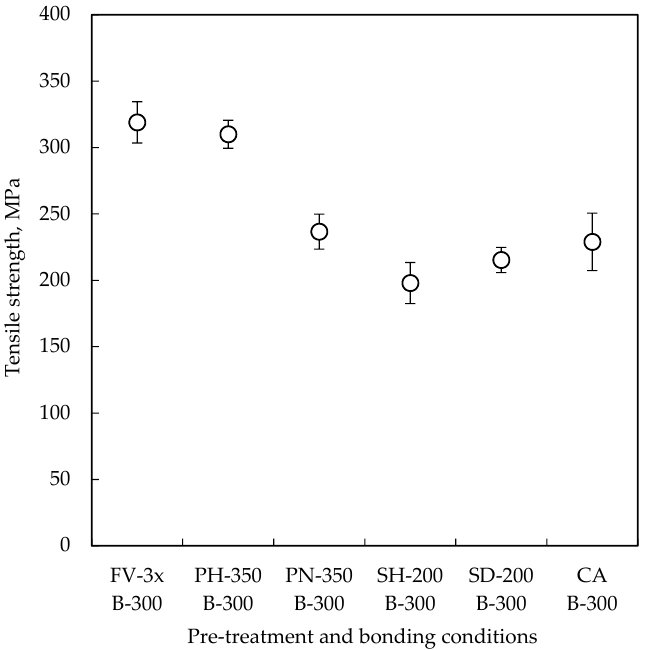
Figure 4. Tensile strengths of the formic acid vapor pre-treated chips at different bonding temperatures. Nine chips were tested in each condition.